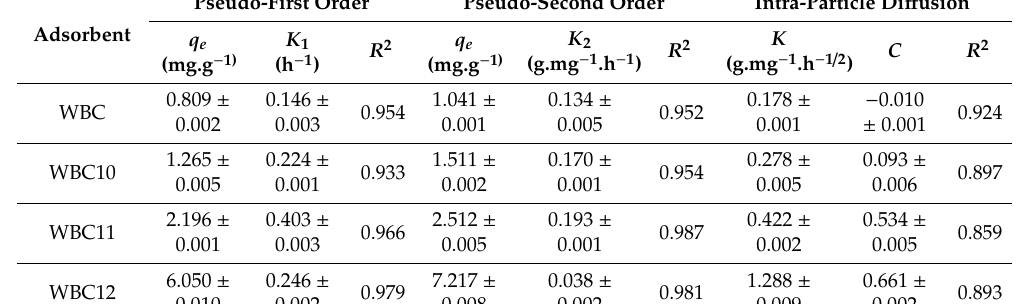
Table 2. Kinetic parameters for pseudo-first order, pseudo-second order, and intra-particle diffusion mechanism of phosphate onto WBC and WBC1x.